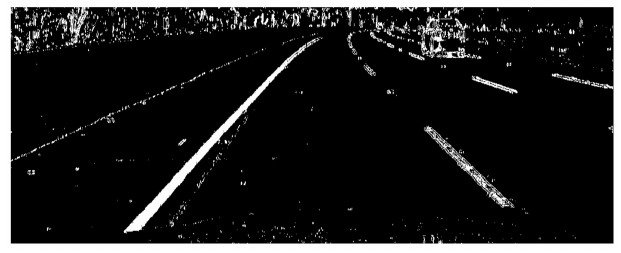
Figure 6. The extracted